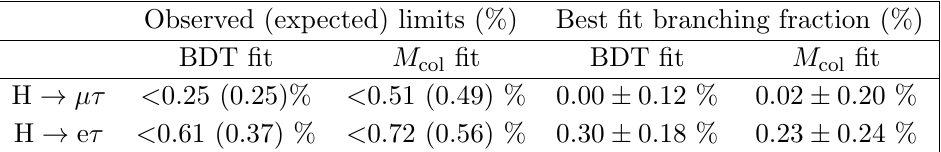
Table 8 . Summary of the observed and expected upper limits at the 95% CL and the best (cid:12)t branching fractions in percent for the H ! (cid:22)(cid:28) and H ! e (cid:28) processes, for the main analysis (BDT (cid:12)t) and the cross check ( M col (cid:12)t) method.